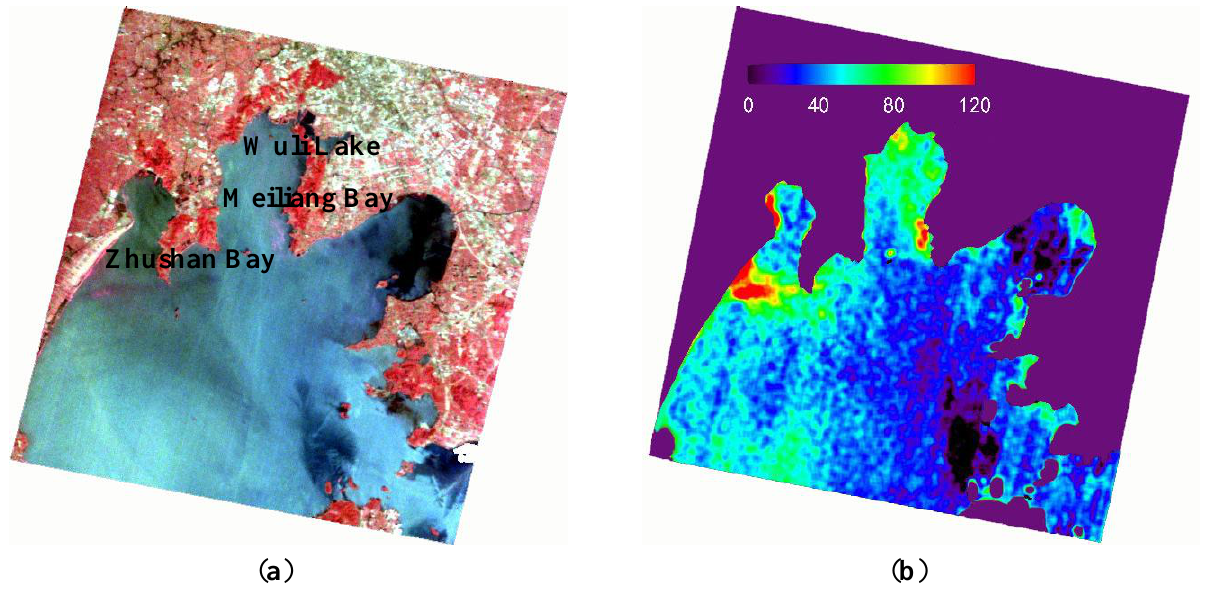
Figure 7. The HJ1/HSI image of Taihu Lake and the estimation result of Chl-a. ( a ) The false color composite image. ( b ) The distribution of